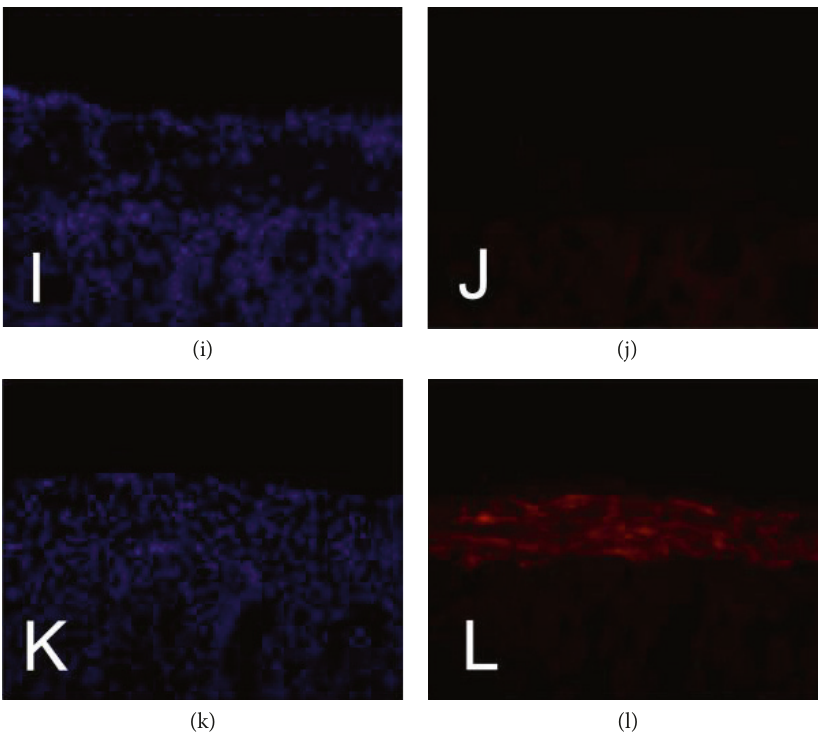
Figure 3: Analysis of graft-bearing kidneys for the presence of GFP + transplanted cells. After immuno fl uorescence analysis of the graft- bearing kidneys using anti-GFP antibody, the number of mice with remaining GFP + cells at the transplant site and the number of mice analyzed in each group were tabulated (a). No di ff erences in the frequency of graft survival between the untreated and preactivated allogeneic groups were observed (b); di ff erences were only found between the allogeneic and syngeneic groups, P < 0 01 , log rank. The allogeneic group 7 days after transplantation (c, d), stained with DAPI and GFP + , respectively. The allogeneic group 14 days after transplantation (e, f). The allogeneic group 14 days after transplantation of preactivated MSCs (g, h). The allogeneic group 28 days after transplantation (i, j). The syngeneic group 100 days after transplantation (k, l). Magni fi cation of